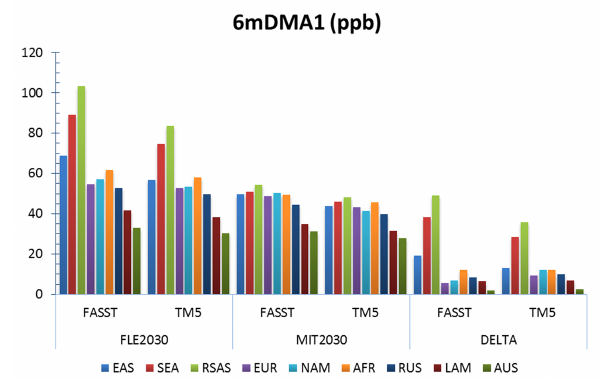
Figure 11. Total population-weighted anthropogenic PM 2 . 5 over larger FASST zoom areas, for the high-emission (FLE2030) and low-emission (MIT2030) scenarios, and the difference (delta) be- tween both, computed with the full TM5 model and with